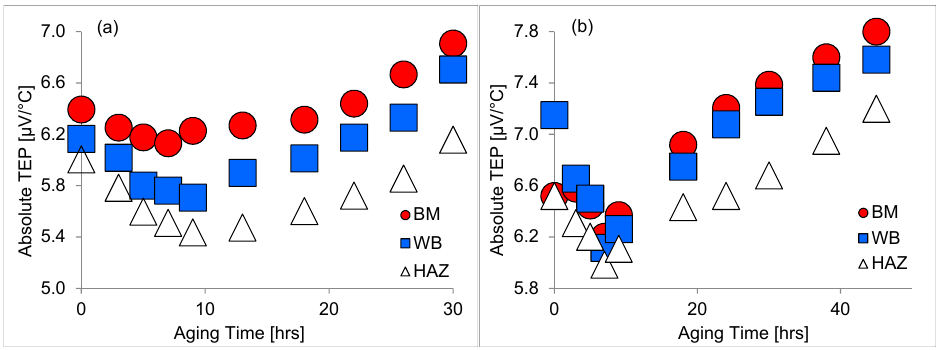
Figure 7. Thermoelectric power measurements of the micro ‐ alloyed steel of ( a ) API X60 and ( b ) API X65 weldments that were artificially aged.